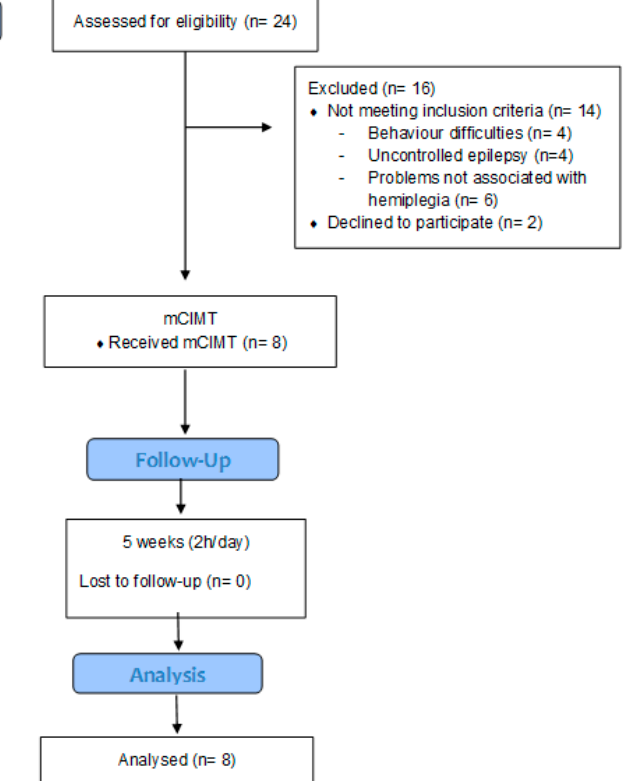
Figure 5. Flowchart of the sample selection.